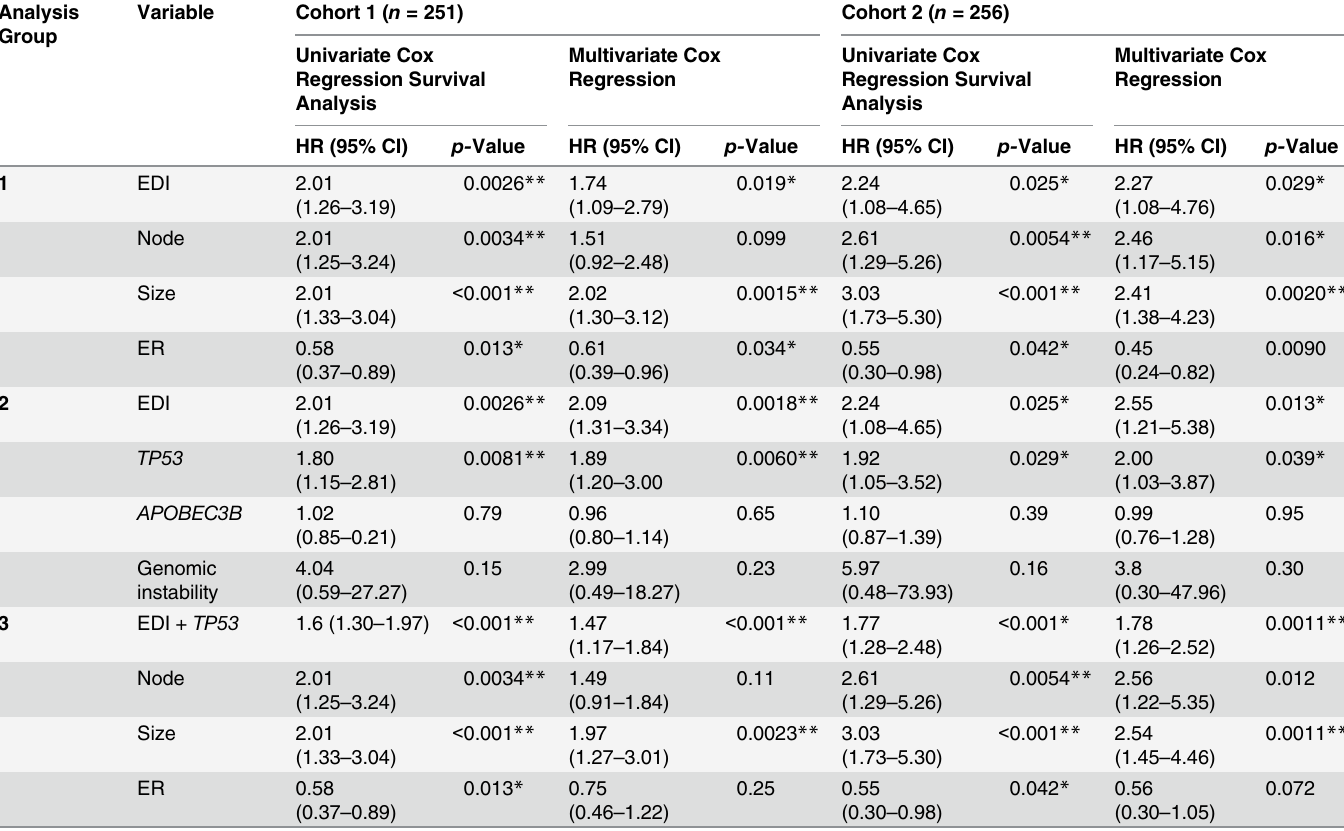
Three groups of analysis are presented. Group 1 includes EDI and classical clinical parameters that are found to be signi fi cant in univariate analysis, including lymph node status (Node), tumor size (Size), and ER status de fi ned by microarray data. Group 2 includes EDI and cancer hallmark measures TP53 , APOBEC3B expression, and genomic instability. Group 3 is a combined analysis of EDI and TP53